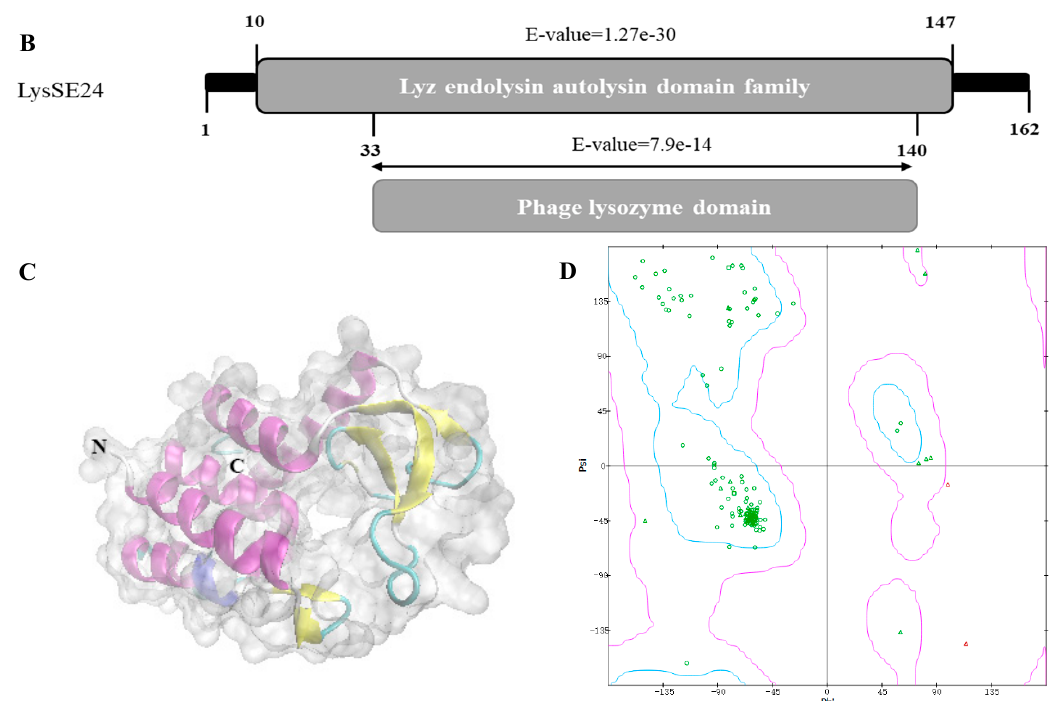
Figure 1. Bioinformatics analysis of LysSE24. ( A ) LysSE24 conserved domain analysis in NCBI Conserved Domain Database (NCMI CDD) and Pfam 32.0. LysSE24 carries out conservative domain search; it belongs to the Lyz endolysin autolysin domain family (Accession cd00737) between10 and 147 aa (E-value 1.27 × 10 − 30 ), while Pfam predicted that LysSE24 had a phage lysozyme domain (Accession PF00959.19) from 33 to 141 aa (E-value 7.9 × 10 − 14 ). ( B ) Multiple alignments of amino acid sequences of LPSE1, W71701E2, ST4, BPS11Q3, SETP13, and phi68 endolysins constructed using Clustal-Omega and software Jalview 2.11.0, and LysSE24 secondary structure prediction. The shades